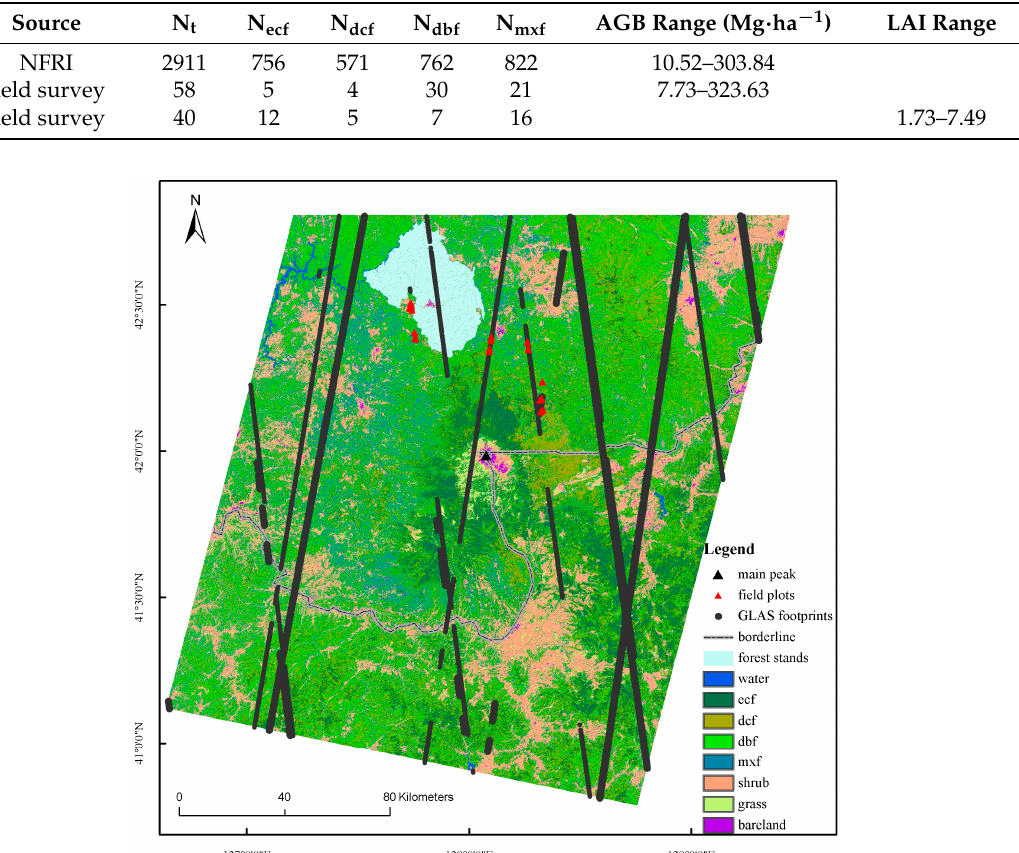
Figure 1. Overview of study area(ecf = evergreen coniferous forests,dcf = deciduous coniferous forests, dbf = deciduous broadleaf forest, and mxf = mixed forest). Table 1. Summary of field data: N t is the total number of all field forest plots; and N ecf , N dcf , N dbf , and N mxf are the total number of evergreen coniferous forest, deciduous coniferous forest, deciduous broadleaved forest, and mixed forest plots, respectively.